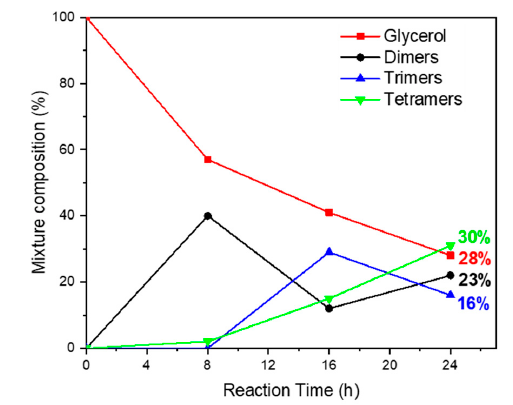
Figure 8. Composition of reaction mixture vs. reaction time.